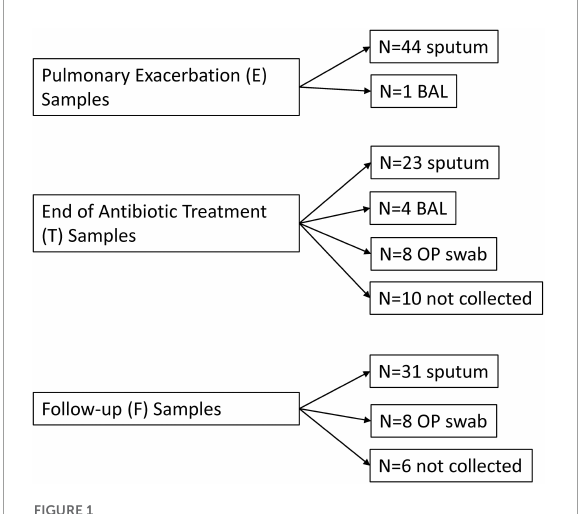
FIGURE1 Flow diagram of respiratory samples by time point. E, pulmonary exacerbation; T, end of antibiotic treatment; F, follow up; BAL, bronchoalveolar lavage; OP,